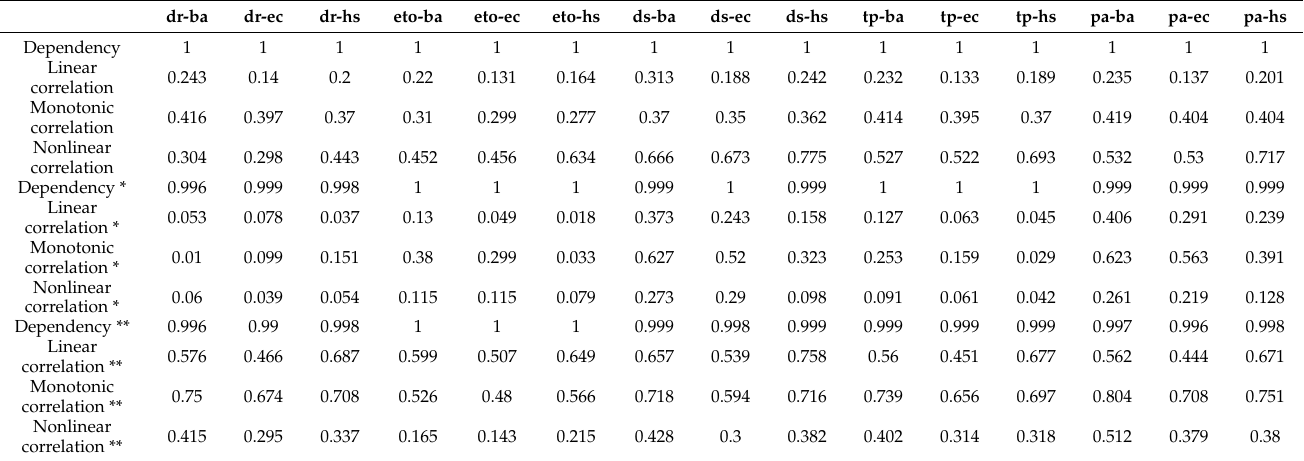
Table 1. Dependency and correlation of paired wildfires with drought